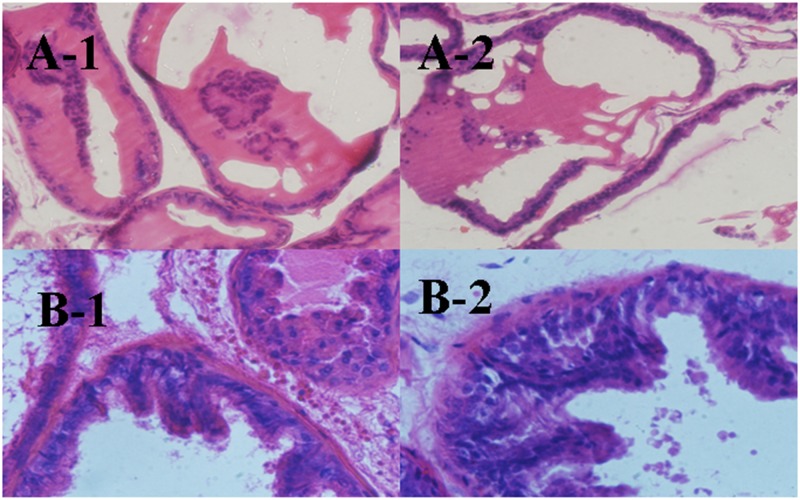
Hematoxylin and eosin staining of prostate ventral lobe (1) and dorsal lobe (2) from sham group rats (A) and BPH induced rats (B).